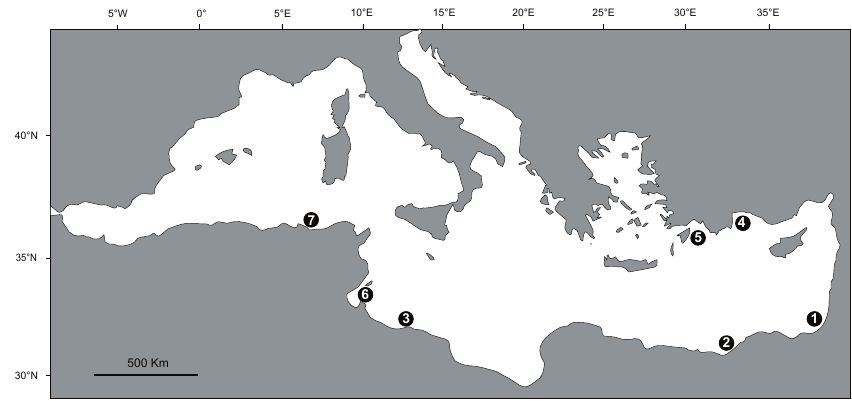
Fig. 1. Map pointing out the capture area of Sphyraena flavicauda on Algerian coasts (7) and chronology of first records in the Mediterranean (1 = Golani 1992; 2 = Allam et al. 1999; 3 = Ben Abdallah et al. 2003; 4 = Bilecenoglu et al. 2002; 5 = Corsini et al. 2005; 6 = Ounifi-Ben Amor et al. 2016)